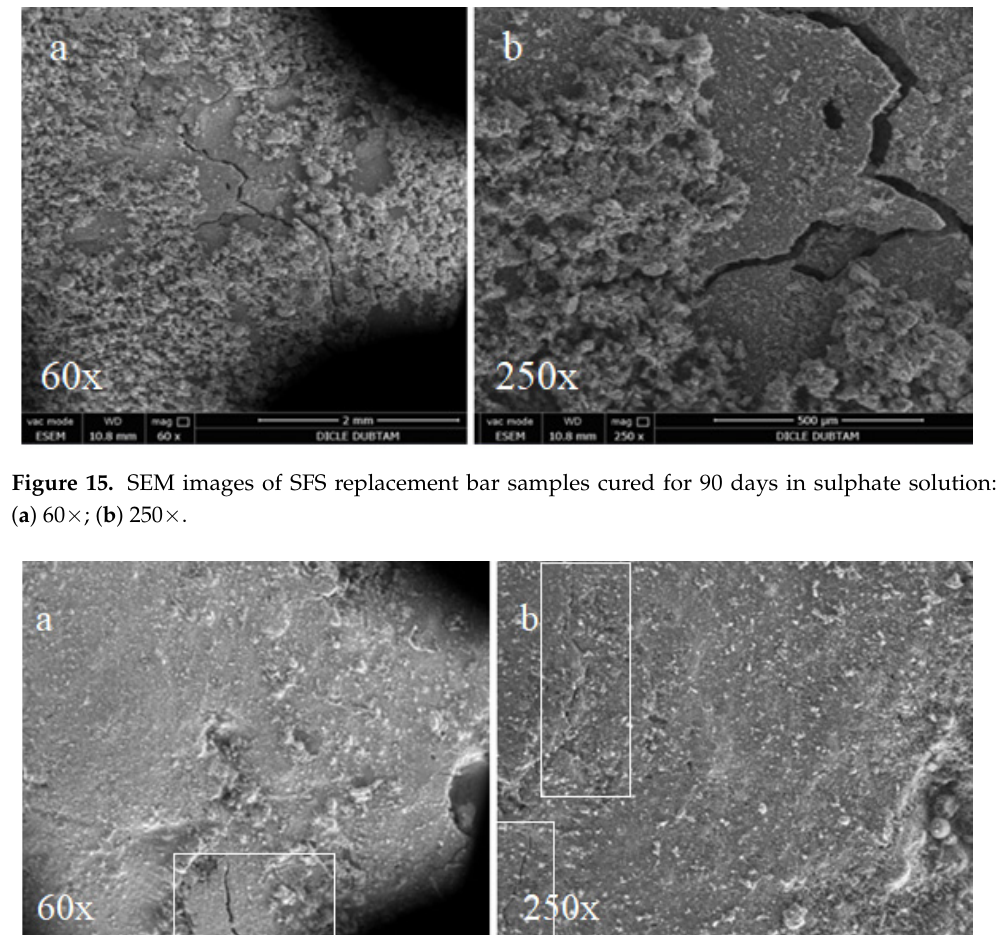
Figure 14. SEM images of control bar samples without replacement cured for 90 days in sulphate solution: ( a ) 60×; ( b )250×; ( c ) 800×; ( d ) 1500×.